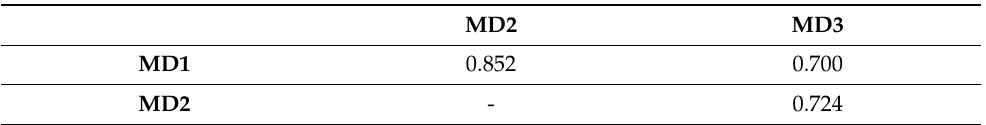
Table 2. Interclass Correlation Coefficient between the three observers after analyzing the 3D printed model.